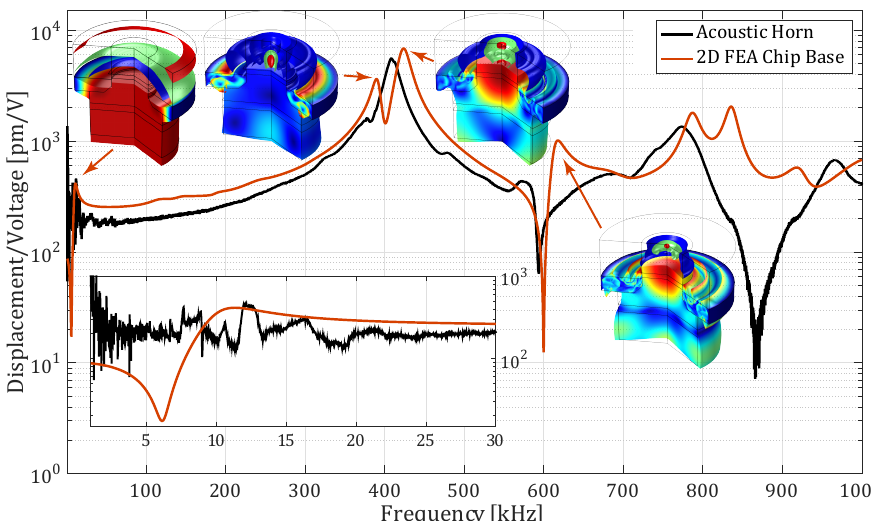
Figure 6. Measured frequency response of the actuator at the chip base compared to the FEA model evaluated at the top of the acoustic horn. In the bottom left corner, a zoom-in of the actuator response at low frequencies is